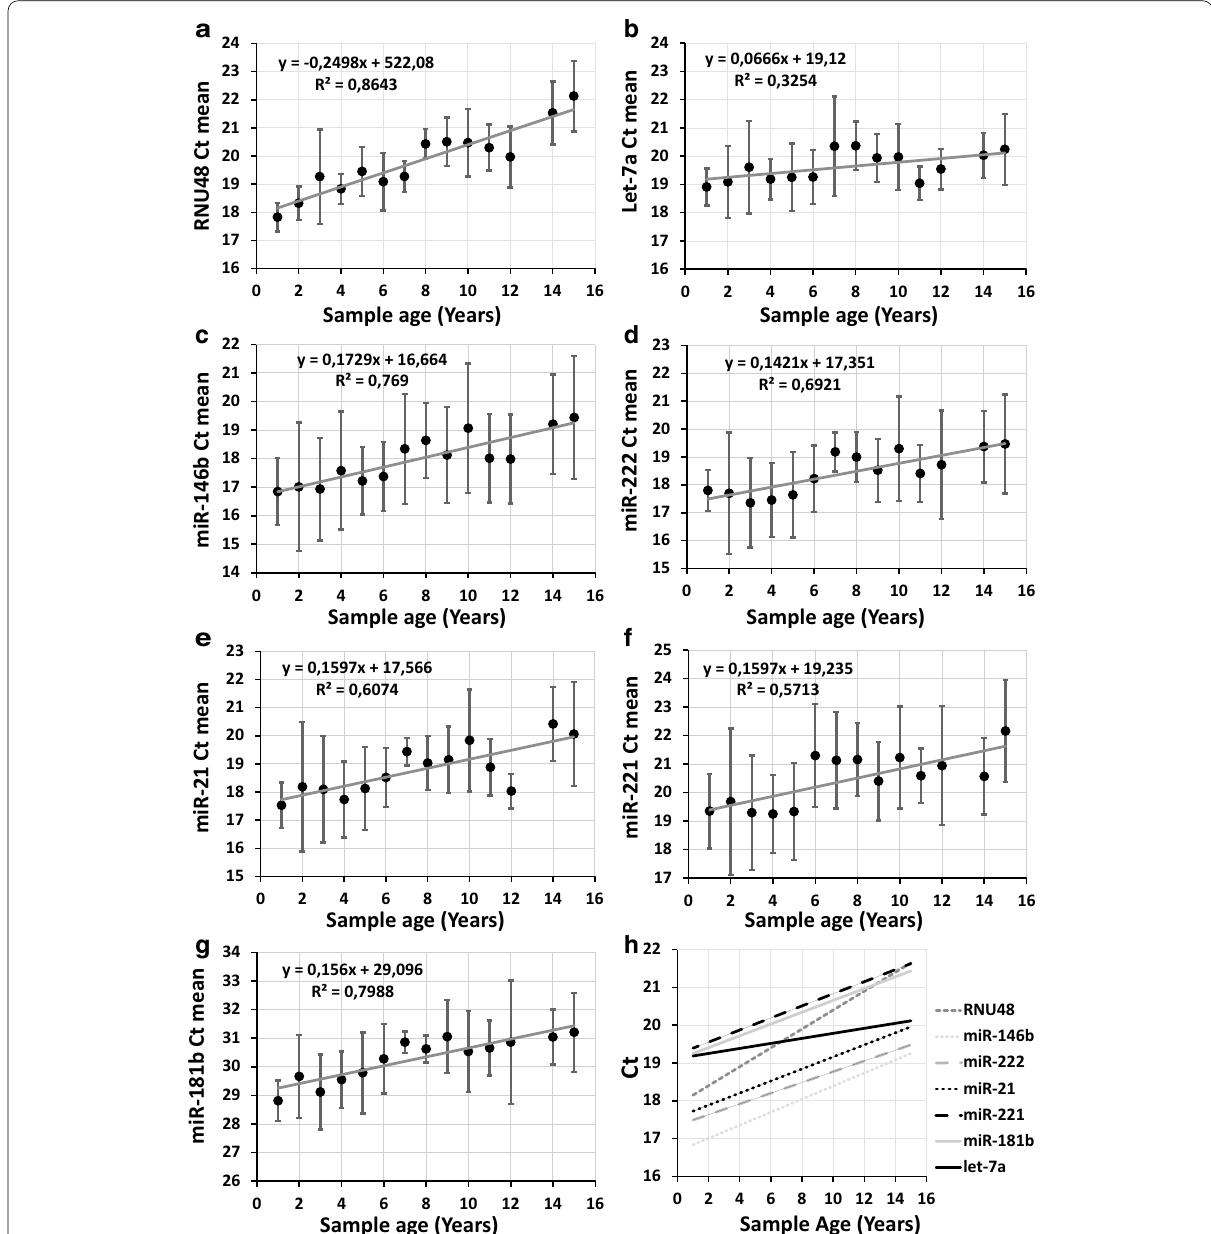
Fig. 2 Differences in endogenous controls and target miRNAs degradation rate. a – g Correlation analysis between PTC FFPE tissue sample age and detected RNU48, let-7a, miR-146b, miR-222, miR-21, miR-221, miR-181b cycle of threshold (Ct). h Combined regression lines of miR-146b, miR-222, miR-21, miR-221, miR-181b and control RNU48, let-7a Ct values against sample age. For this graph miR-181b regression line is lowered by 10